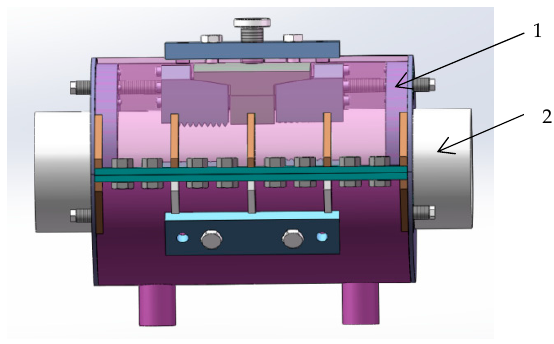
Figure 10. Variation of clamp wave flow force on horizontal steel tube with wavelength and water depth.